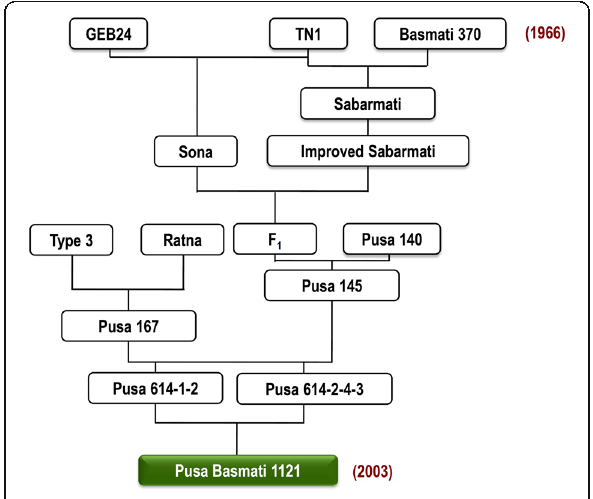
Fig. 2 Lineage of PB 1121 showing the contribution of several varieties including the traditional Basmati rice varieties Basmati 370 and Type 3. Values in parentheses are the year in which crossing was initiated (1966) and the year of release of the variety